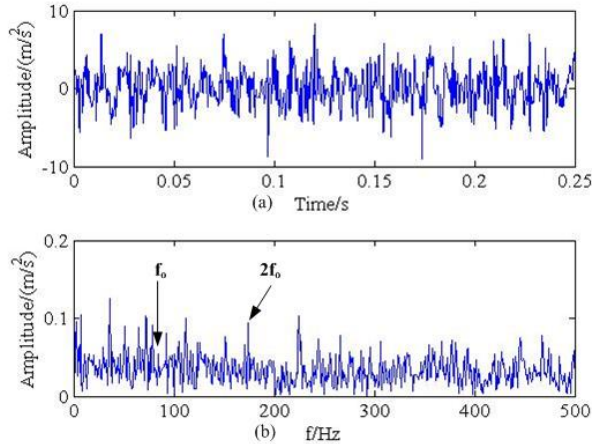
Figure 6. Results obtained by typical wavelet denoising, (a) Reconstructed signal in time ‐ domain by wavelet; (b) Reconstructed signal in frequency ‐ domain by wavelet.